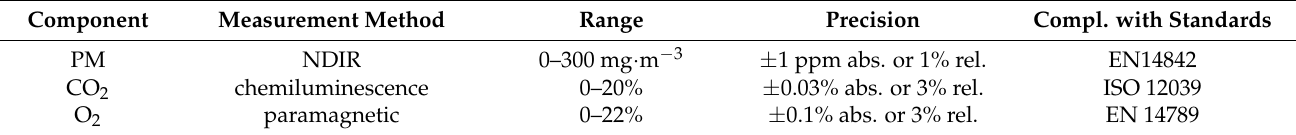
Table 4. Technical data of the Testo 380